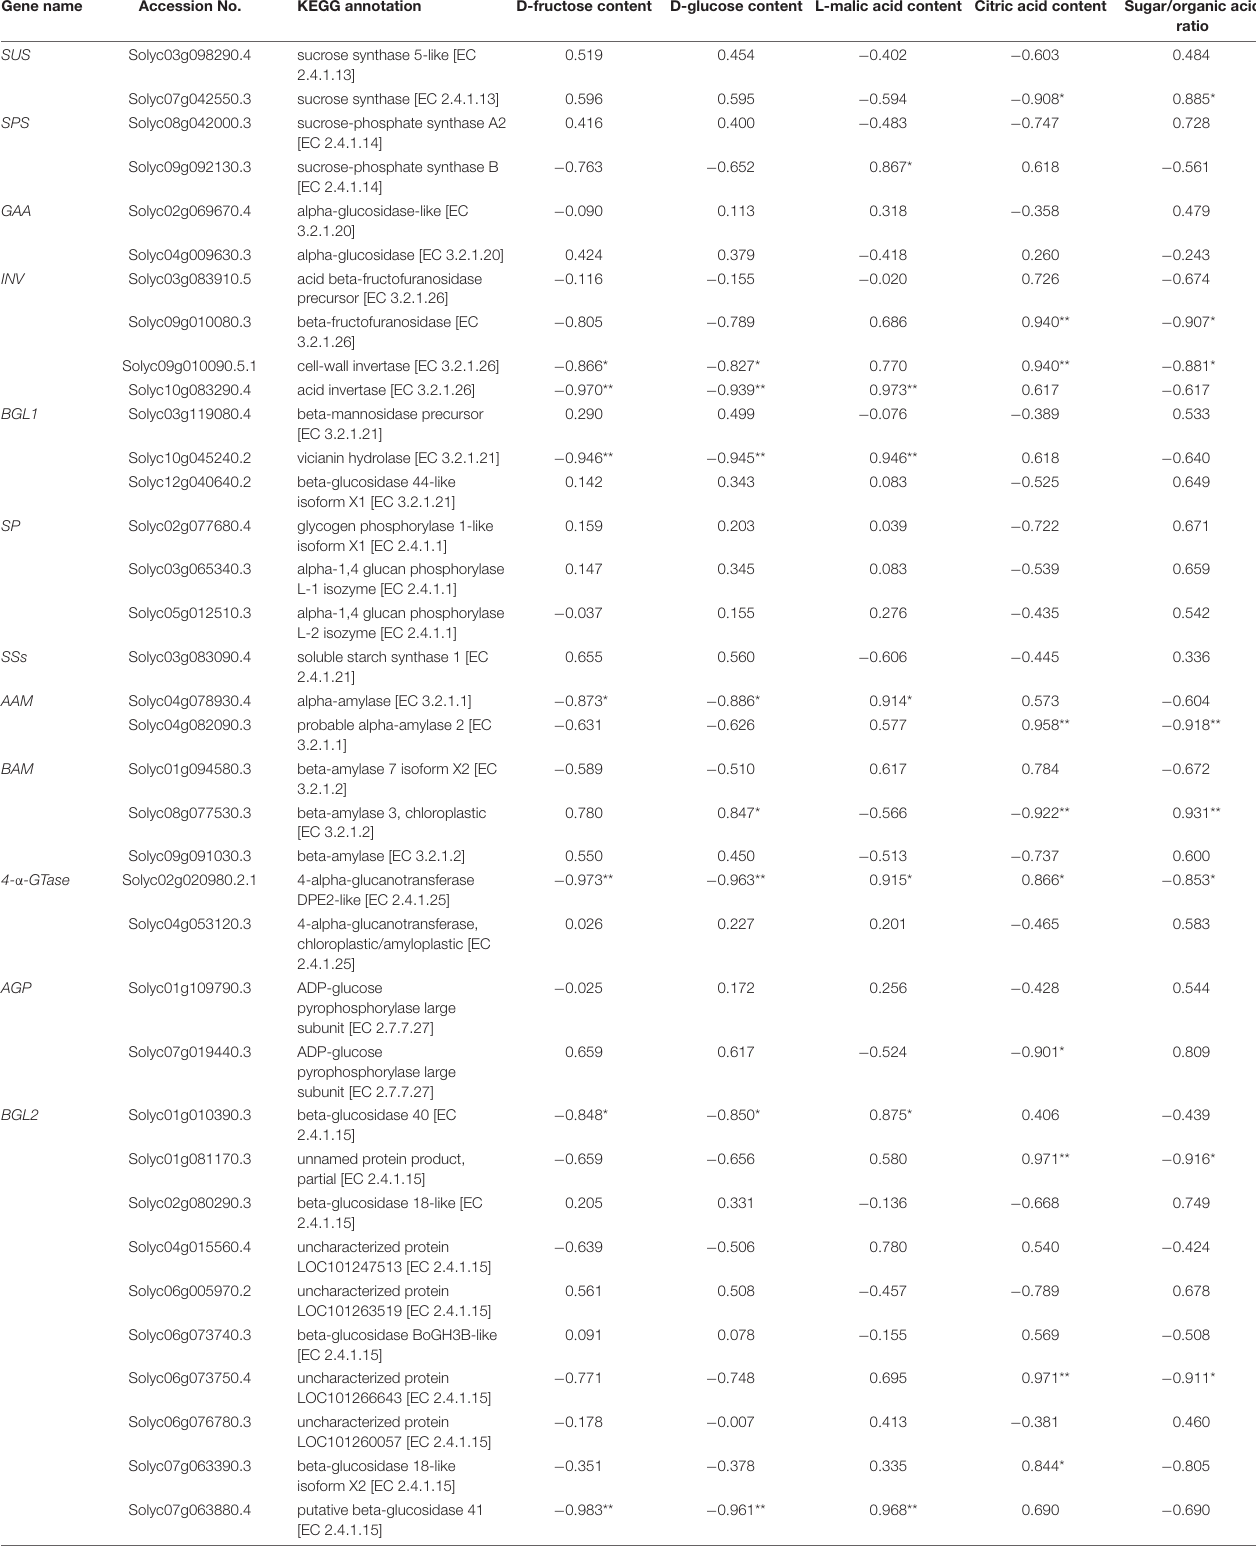
TABLE 2 | Correlation analysis of mean FPKM value of the starch and sucrose metabolism (ko00500) genes with D-fructose, D-glucose, L-malic acid, and citric acid contents, respectively. Gene name Accession